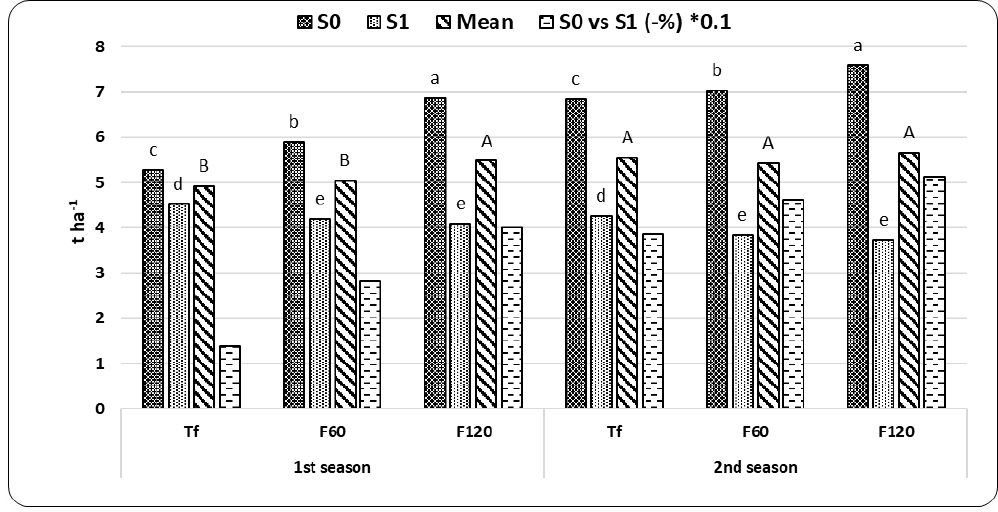
− 1 ) under di ff erent planting methods (M) and salinity conditions Figure 2. Grain yield (ton ha −1 ) under different planting methods (M) and salinity conditions (S). Figure 2. Grain yield (ton ha